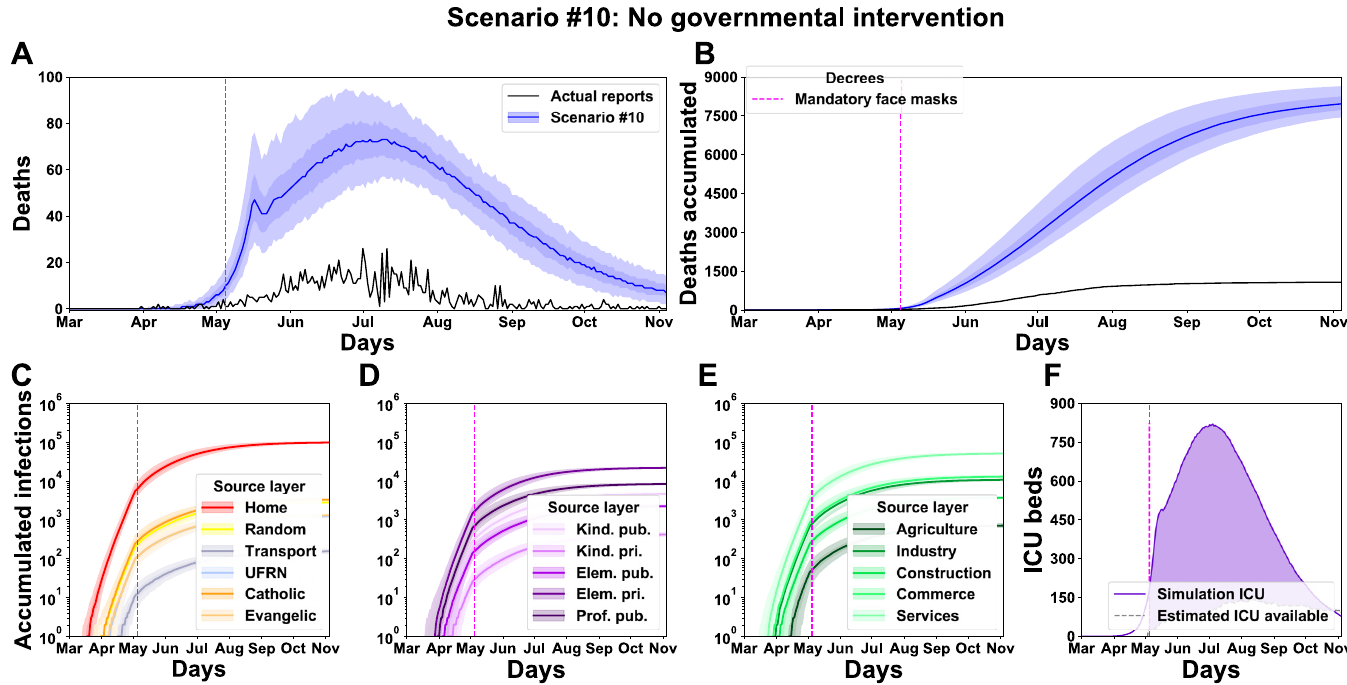
Fig 9. Simulation of a scenario without any decree implies a catastrophic scenario. Results for a baseline scenario altered for the condition that no decree was ever published. Panels from A to F, as in Fig